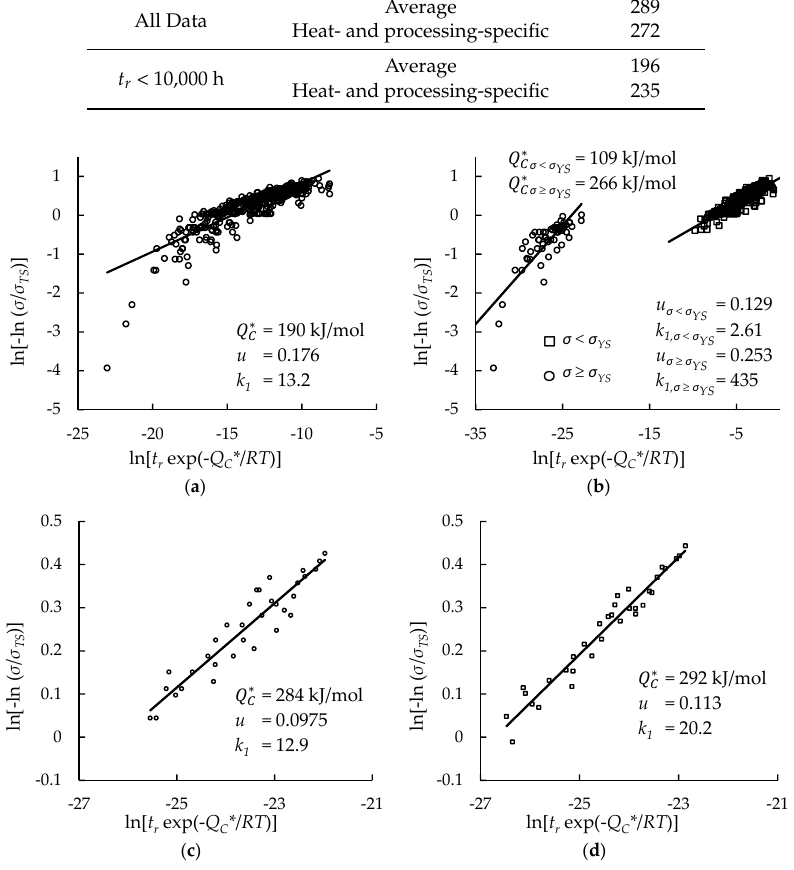
Table 4. Nimonic 105 Q ∗ values (kJ/mol) determined by optimizing the correlation of data on Wilshire plots.